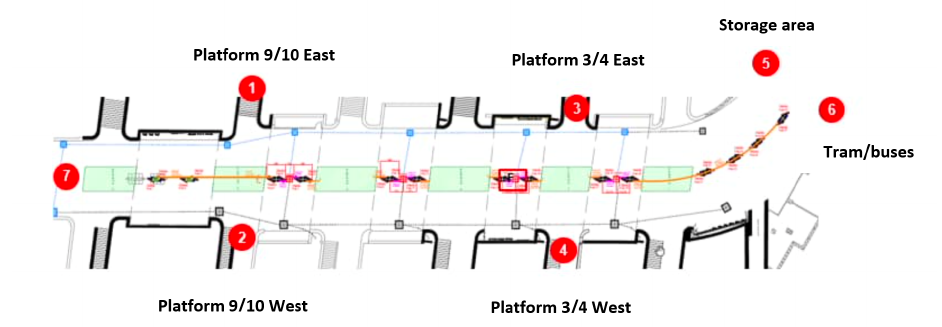
Figure 2. The investigated passage leads to the train station platforms. Access to the platforms is possible by taking a stair or ramp on either the left- or right-hand side of the passage. The red points mark the various starting points and aims for the scenarios. Additionally, points 7 and 6 mark the main entrance/exit of the train station.